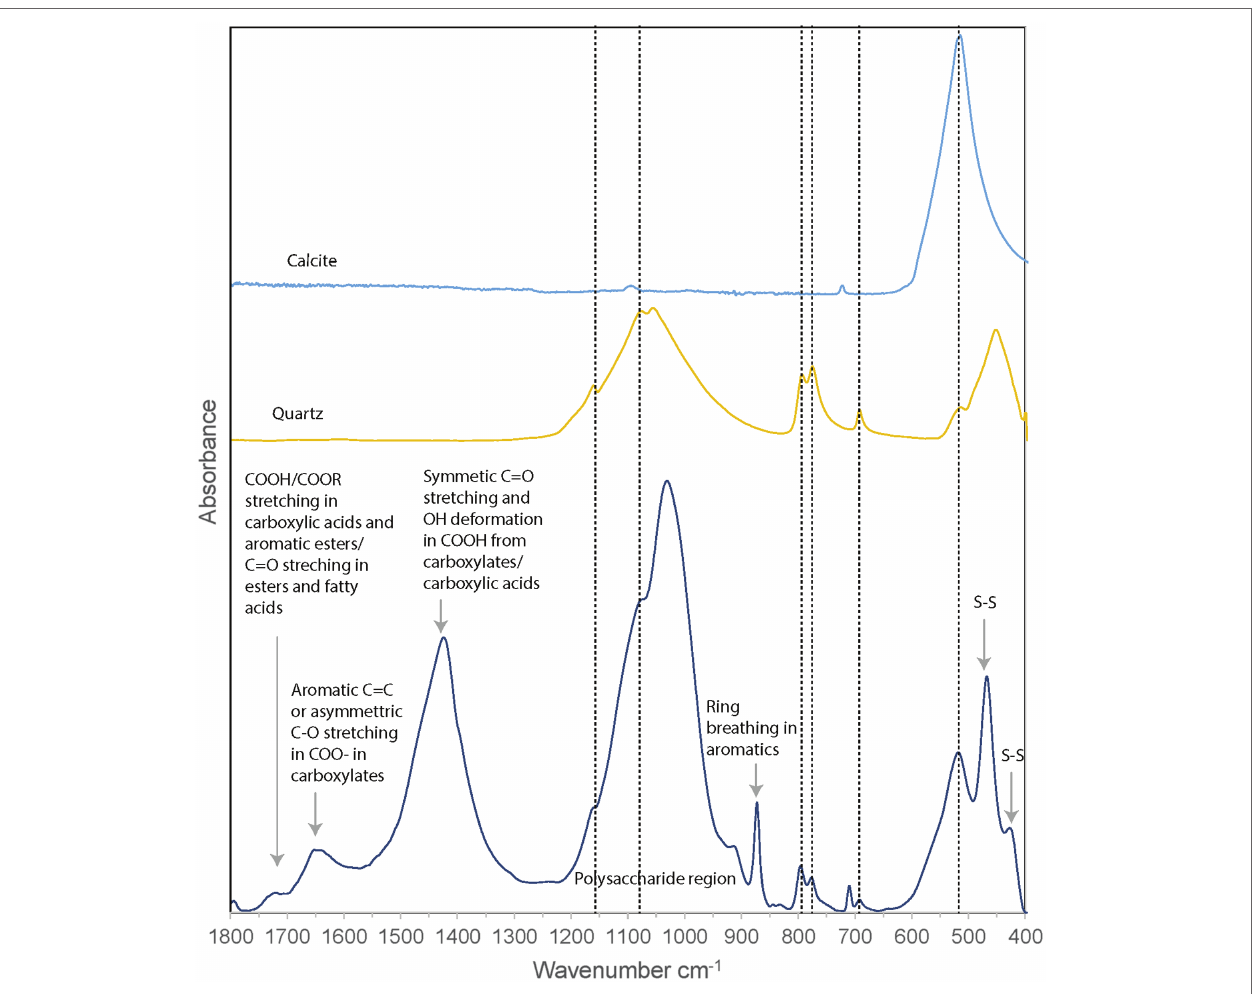
FIGURE 6 | FTIR spectrum of Sulfurovum -dominated streamer biofilm (sample PC1718), plotted with reference spectra for calcite and quartz. Dashed vertical lines indicate the positions of the peaks corresponding to calcite and